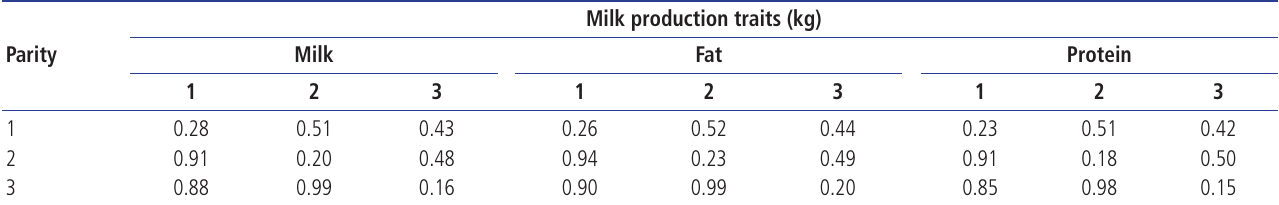
Diagonal, heritability; upper triangle, phenotypic; lower triangle, genetic